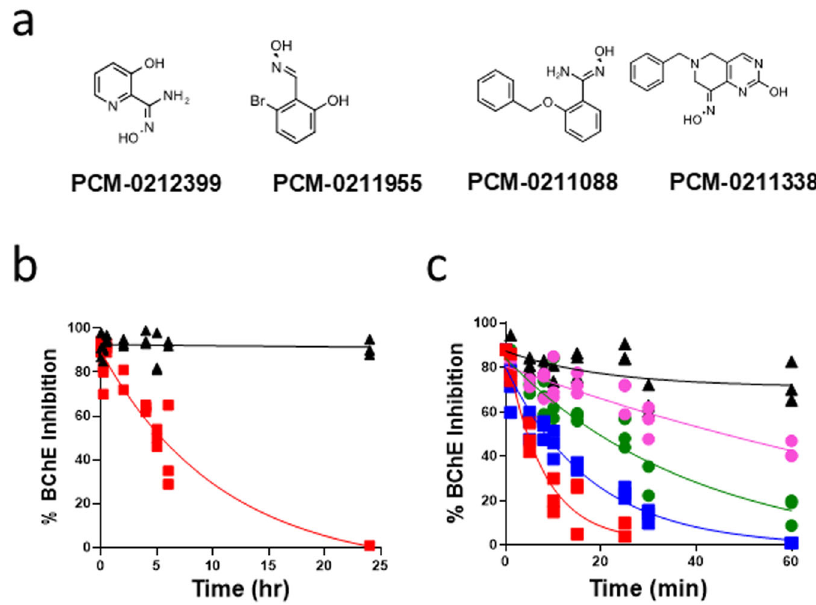
Fig. 1 Structure of HTS-discovered oximes and nerve agent detoxi fi cation by oximes. a Chemical structure of HTS-discovered oximes (IUPAC names appear in Supplementary Information page 1 under Supplementary Scheme 1). b Time-Course of VX detoxi fi cation by PCM-0212399, VX detoxi fi cation measured by enzyme rescue assay. [VX] = 1 µ M [PCM-0212399] = 0.5 mM (red squares). c Sarin detoxi fi cation by PCM-0212399 (red squares), PCM-0211955 (blue squares) PCM-0211338 (green circles), and PCM-0211088 (purple circles) measured by the enzyme rescue assay. [Sarin] = 1 µ M, [Oximes] = 0.5 mM, 20 mM phosphate pH = 8.0 (black triangles), 25 °C. Data are provided in Supplementary Data fi le 1. Table 1 The kinetics of VX- and sarin-detoxi fi cation, and sarin-BChE and VX-BChE reactivation by HTS-identi fi ed oximes.